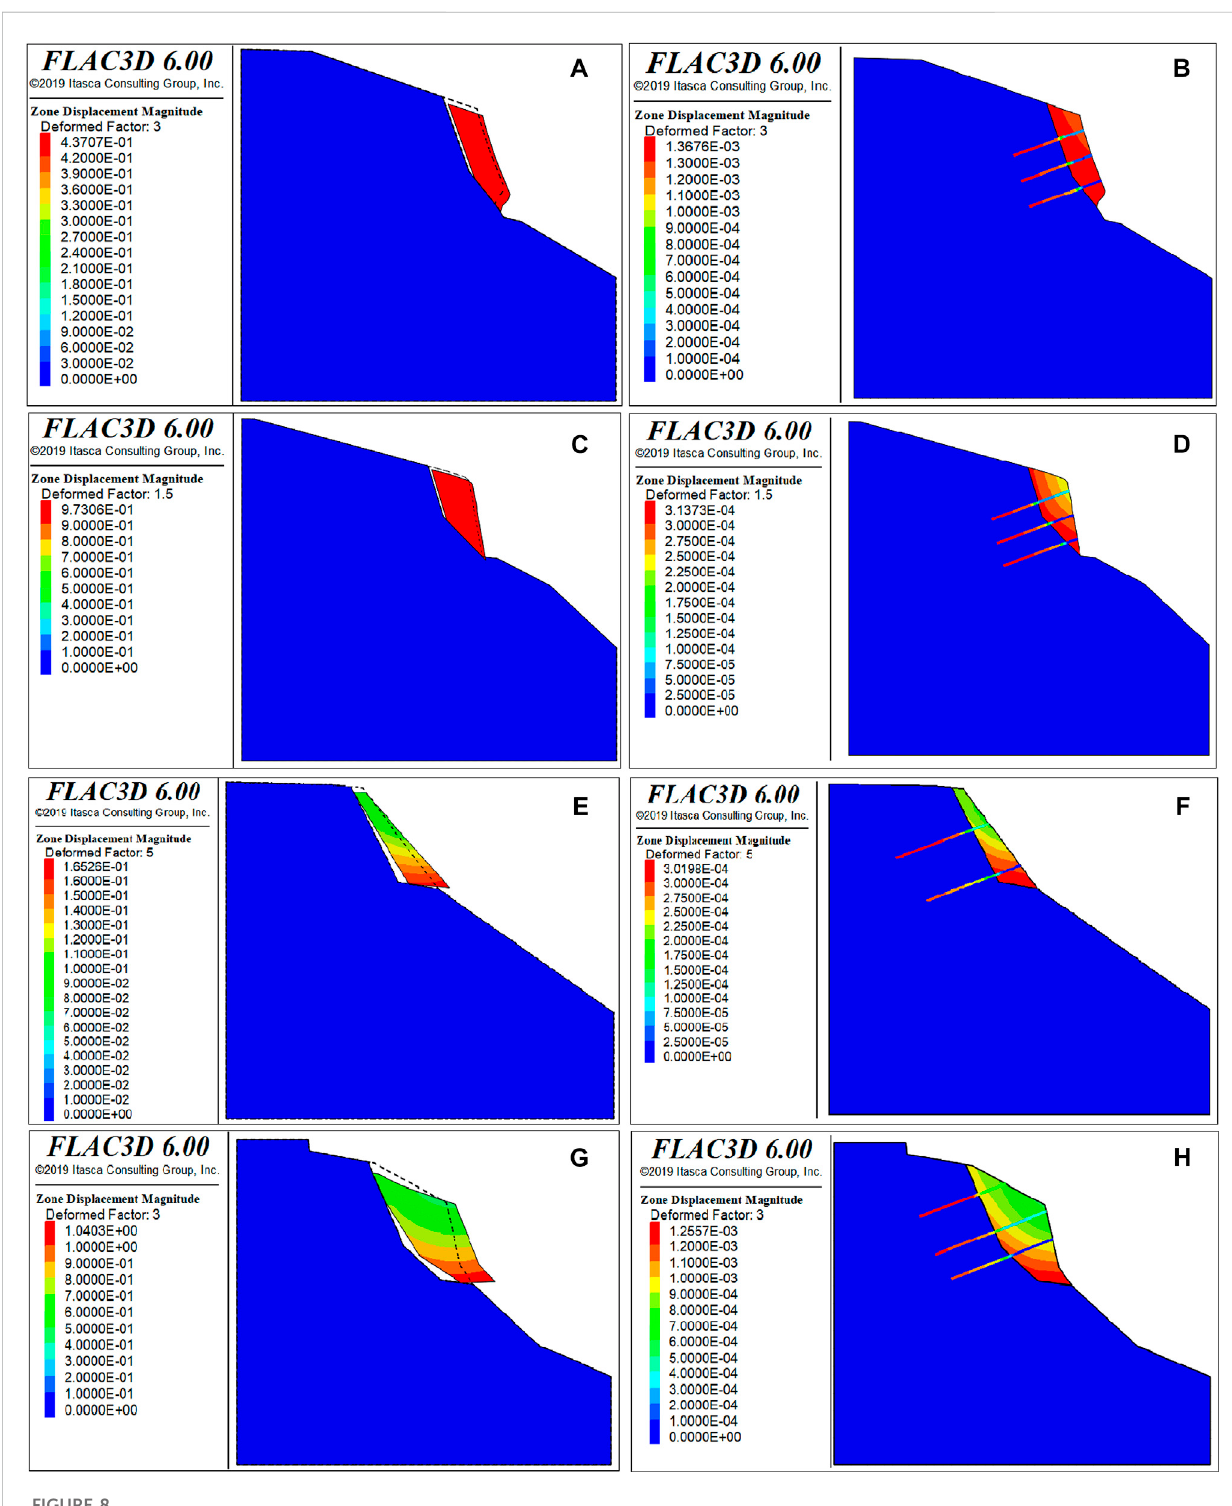
FIGURE 8 Displacement comparison of before and after bolt support. (A) Before bolt support of W1. (B) After bolt support of W1. (C) Before bolt support of W2. (D) After bolt support of W2. (E) Before bolt support of W6. (F) After bolt support of W6. (G) Before bolt support of W7. (H) After bolt support of